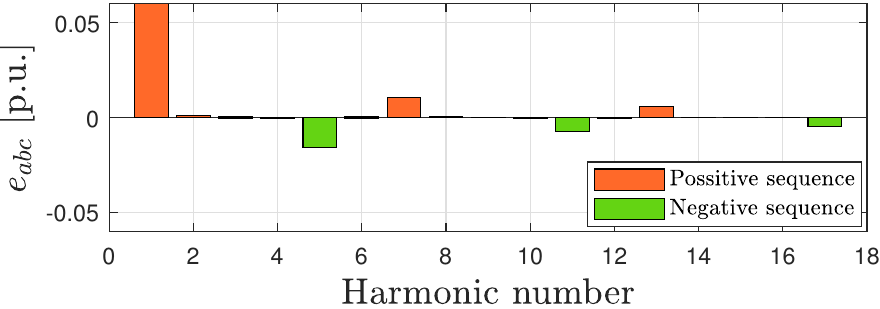
Figure 9. Voltage harmonic spectrums of proportional-integral passivity-based controller